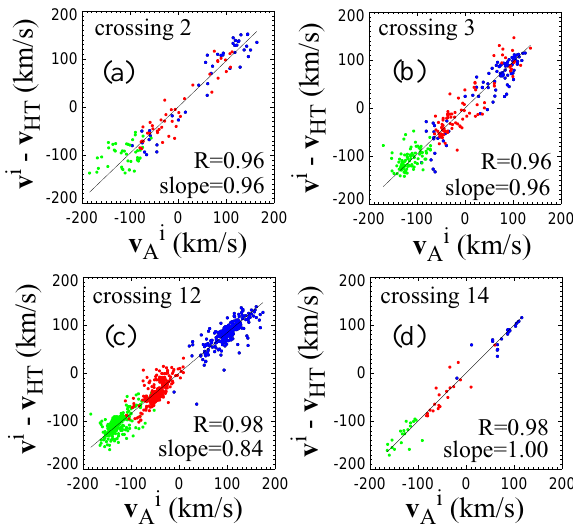
Fig. 6. Spacecraft 1 GSE ion velocity in the HT frame versus the Figure 6. Spacecraft 1 GSE ion velocity in the HT frame Alfv´en velocity for (a) crossing 2, (b) crossing 3, (c) series of versus the Alfvén velocity for (a) crossing 2, (b) crossing 3, (c) FTE at 11:25 UT, (d) series of smaller amplitude FTEs at smaller amplitude FTEs at 11:05–11:25UT, (d) FTE at 11:30UT. 11:05-11:25 UT. The blue, green, and red dots denote the x, y, The blue, green, and red dots denote the x, y, and z components, and z components, respectively. respectively.